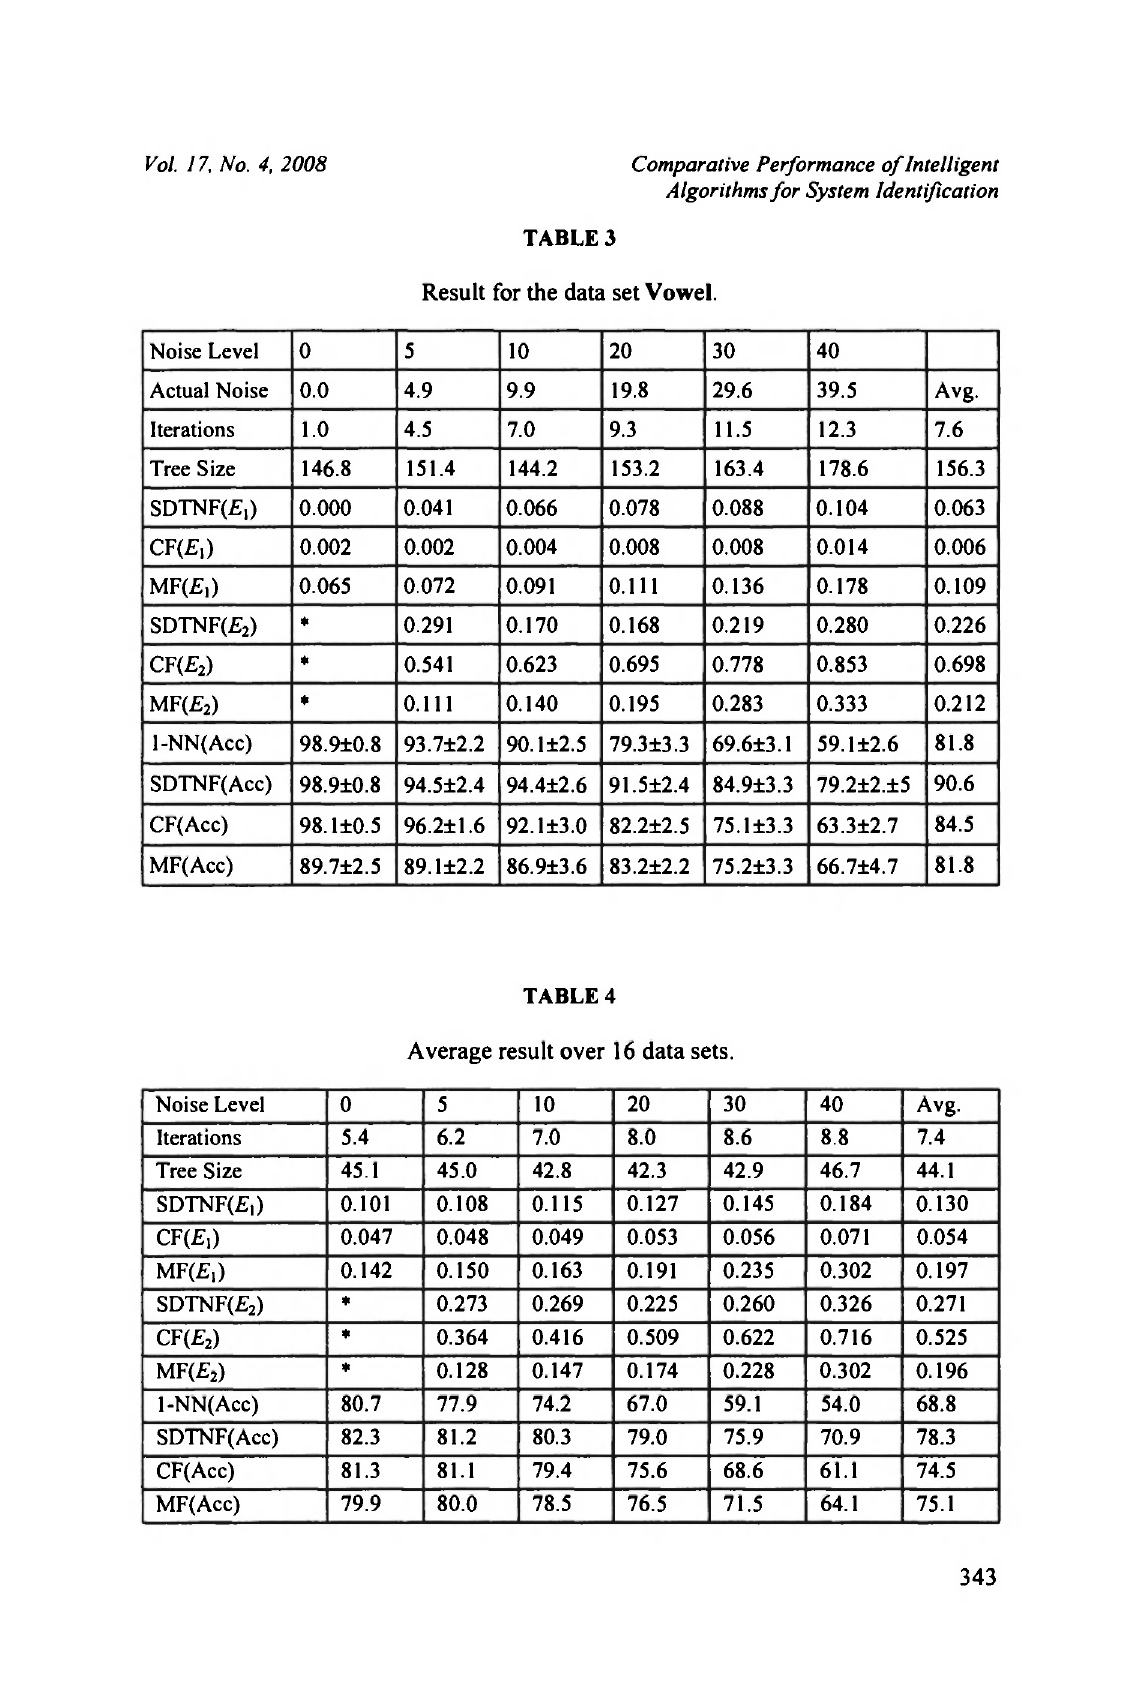
Average result over 16 data